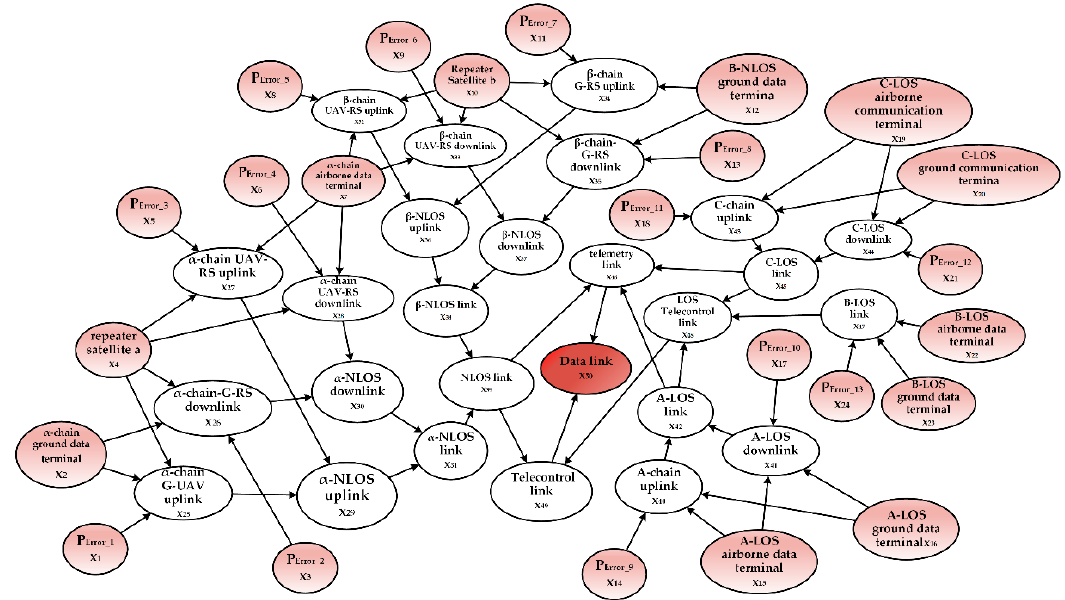
Figure 7. Directed acrylic graph of a solar-powered UAV data-link system.